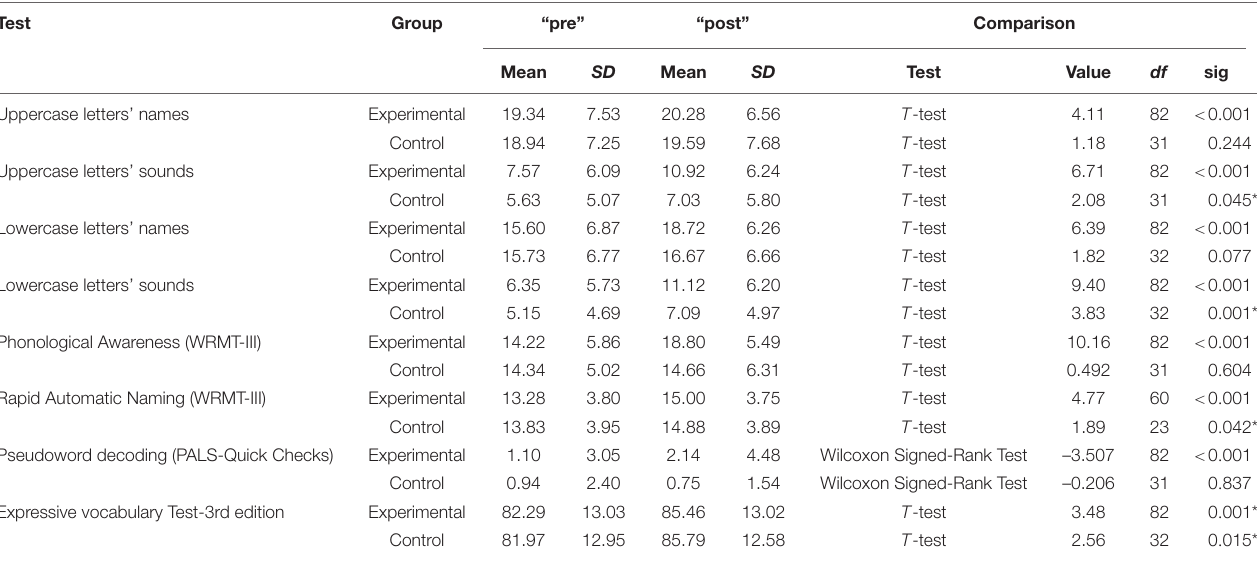
TABLE 4 | Paired-sample T -test for the “pre” and “post” measures by